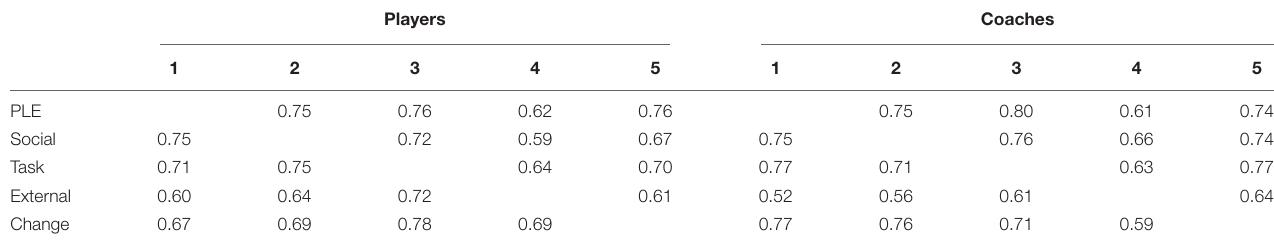
TABLE 2 | Correlations for all study